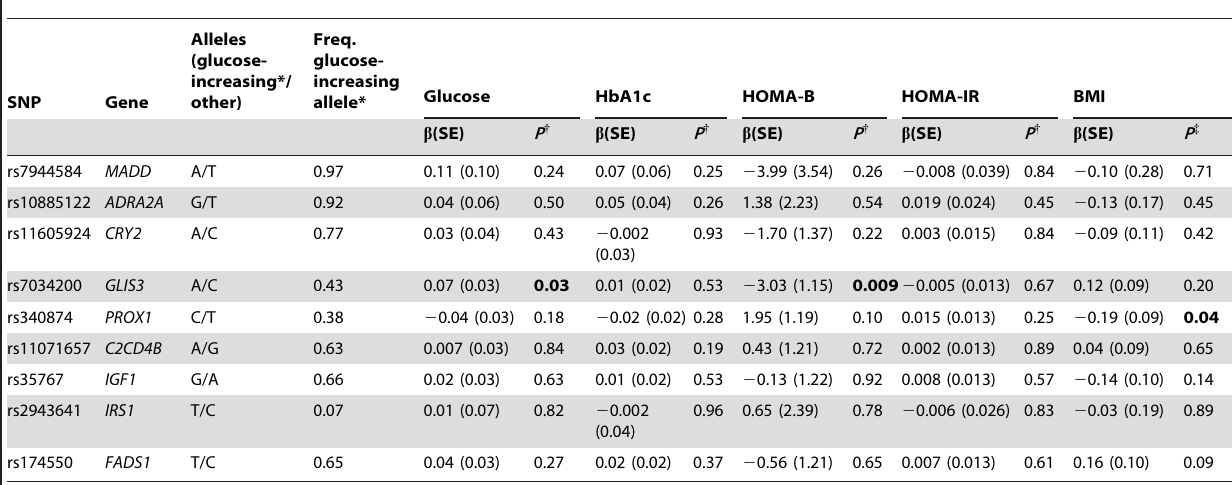
Table 2. Associations with type 2 diabetes-related quantitative